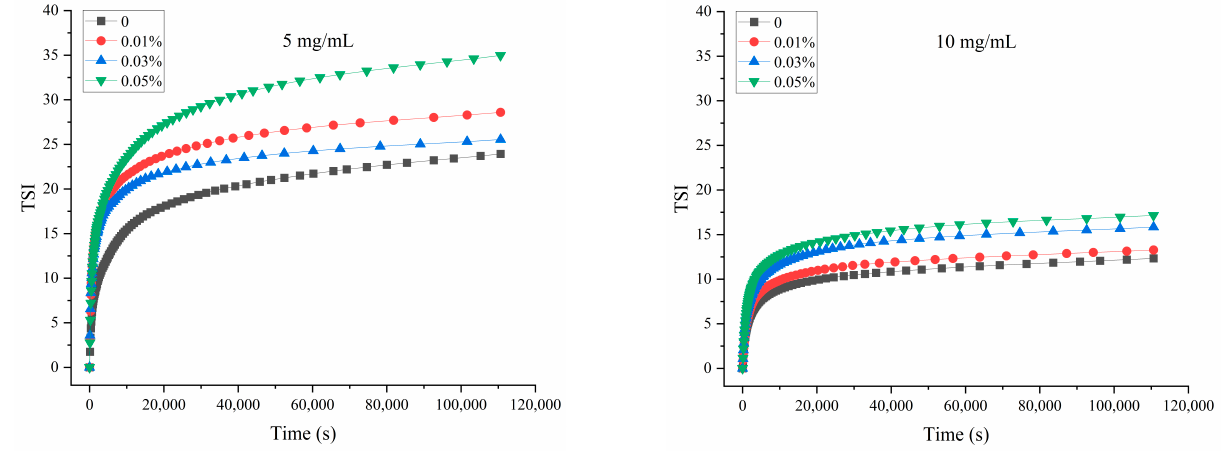
Figure 4. The TSI of MP O/W emulsion with different concentrations of TPP during 30